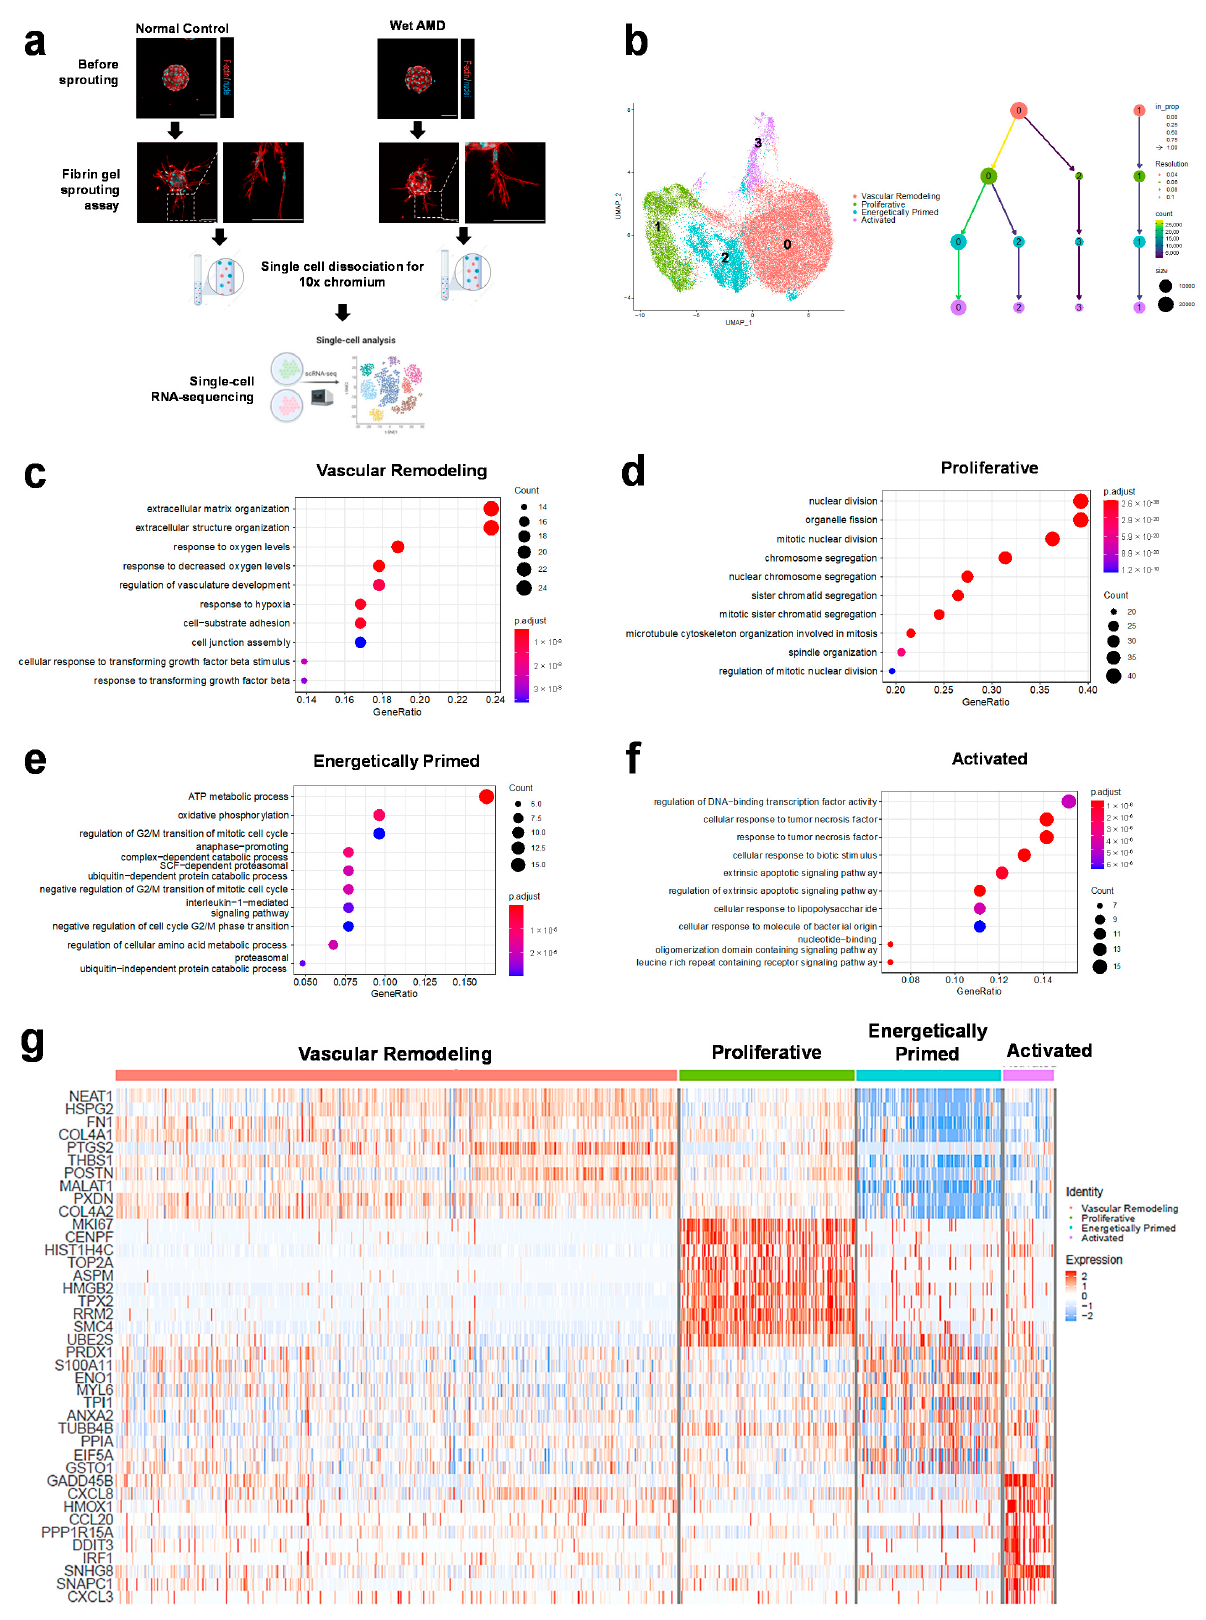
Figure 1. Human blood outgrowth endothelial cells adopt distinct cell states during